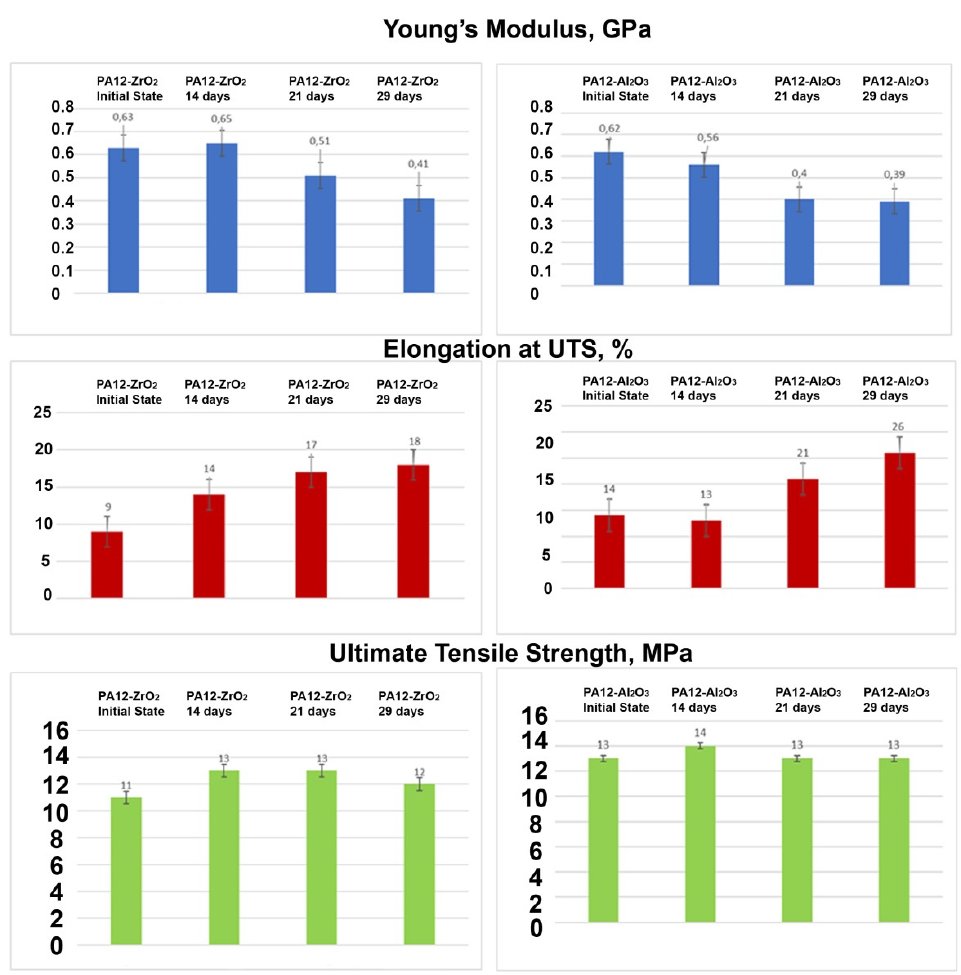
Figure 16. Young’s modulus, elongation at ultimate tensile strength, and ultimate tensile strength, of the composite materials PA12-ZrO 2 and PA12-Al 2 O 3 .